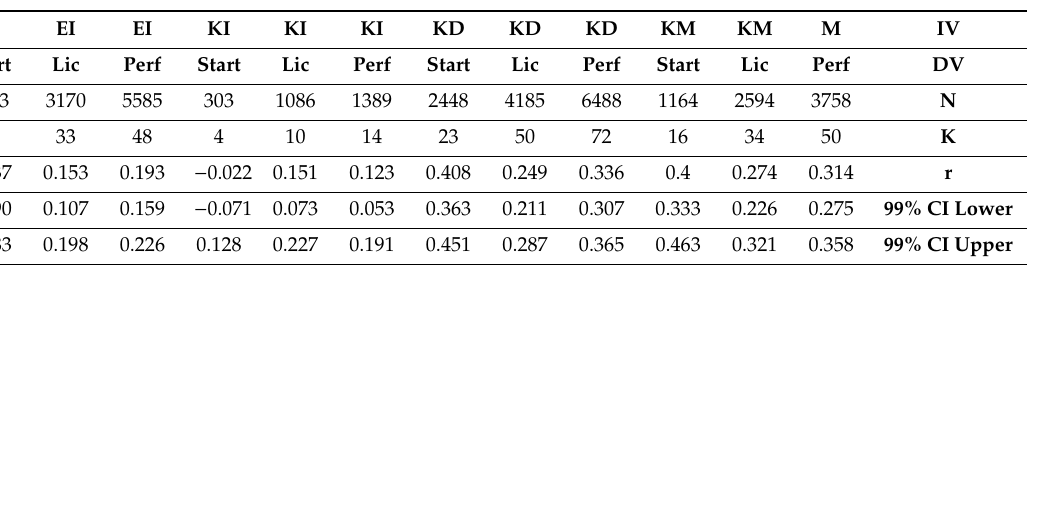
Table 5. University technology transfer meta-analysis results using a fixed e ff ects